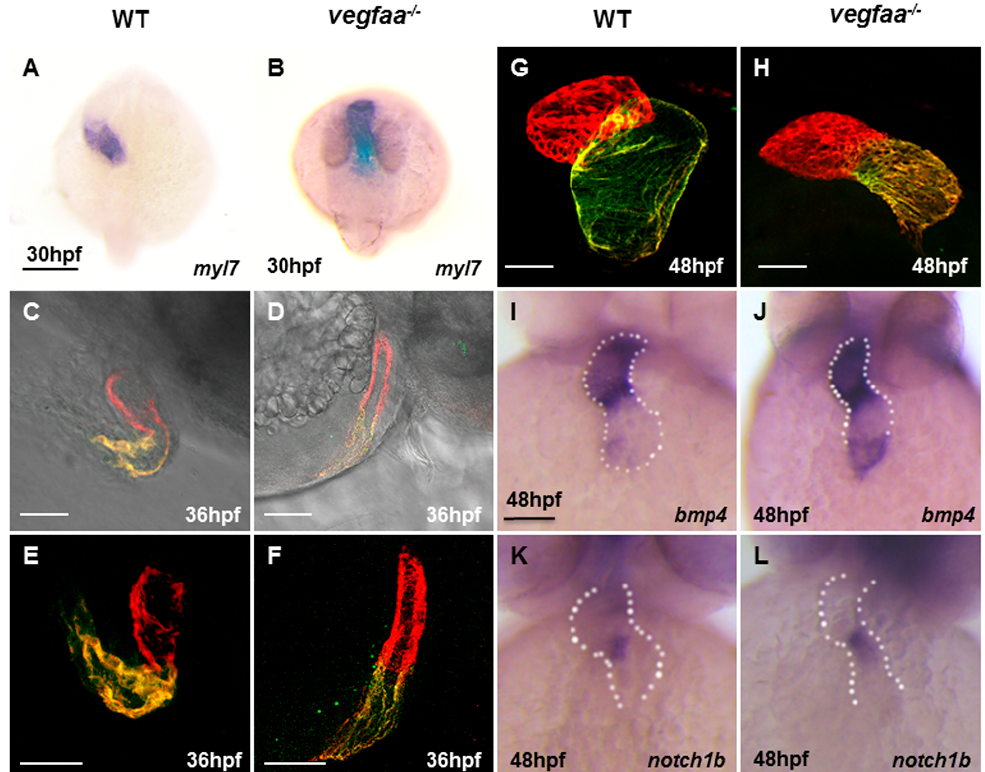
Figure 4. vegfaa deficiency results in defects in cardiac looping and chamber formation. ( A , B ) Dorsal views of in situ hybridization depicts myl7 expression at 30 hpf in wild-type embryos ( A ) and vegfaa mutant embryos ( B ). Scale bar: 200 μ m ( A , B ); ( C – F ) Lateral views of zebrafish hearts stained with MF20 (red) and S46 (green) antibodies to visualize the ventricle and atrium at 36 hpf. MF20 marks the whole heart, whereas S46 is atrium-specific. Scale bar: 50 μ m. ( C , D ) are added with light microscopy; ( G – H ) At 48 hpf, the wild-type heart is looped, with morphologically distinct chambers, whereas the vegfaa mutant heart appears unlooped, with a small heart, especially ventricle. Scale bar: 50 μ m ( C – H ); ( I – L ) Frontal views depict expression of the atrio-ventricular canal (AVC) markers in wild-type ( I , K ) and in vegfaa mutants ( J , L ) at 48 hpf. Dotted lines outline the chambers flanking the AVC. Scale bar: 100 μ m ( I – L ).